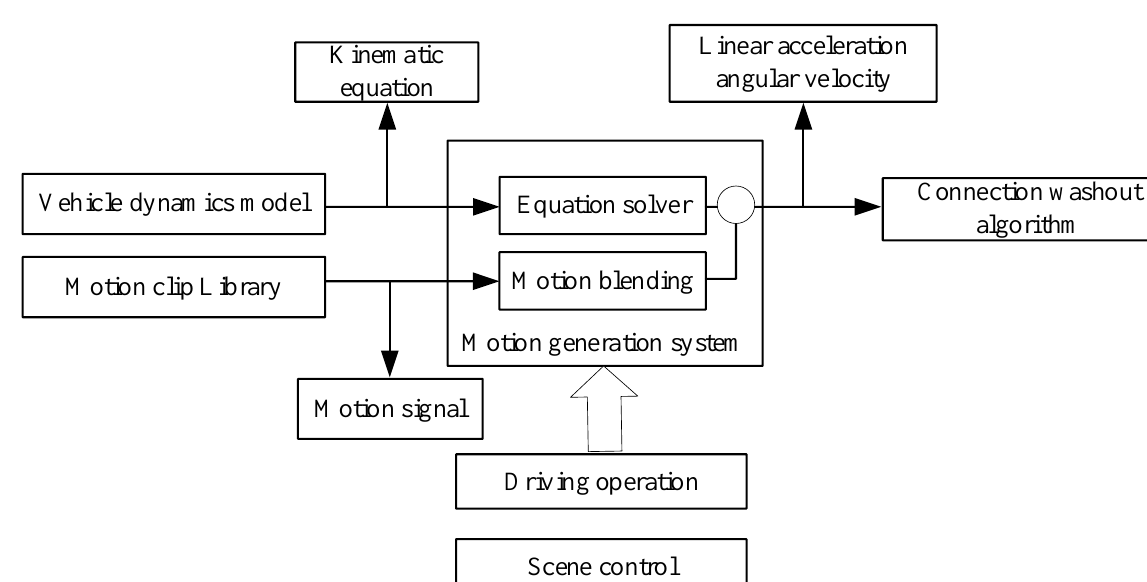
Figure 6. Crane motion simulation based on motion blending technology. 3. Streamlined Motion Blending Technology for Crane Motion Simulation 3.1. Analysis of Streamlined Motion Blending Technology The crane motion simulation scheme based on motion blending shown in Figure 6 can also be further optimized according to the characteristics of crane motion. In the motion components of the crane, the large-scale low-frequency motion caused by the acceleration and deceleration of the trolley needs to be separated by low-pass filtering, and replaced by the tilt coordinate method with the equivalent rotation motion. The motion platform can reproduce other small-scale high-frequency motions. Since the low-frequency motion and high-frequency motion are naturally separated from each other from the moment they are generated, it is only necessary to combine the low-frequency channel motion components converted by the tilt coordinate method with the high-frequency channel mo- tion components as the final driving instructions issued to the motion platform to realize the motion simulation of the crane motion with high fidelity. The structural diagram of the motion simulation system of the streamlined crane pro- posed in this paper is based on the improvement of the traditional motion blending tech- nology (as shown in Figure 7). Though, for this way to develop a dynamic simulation system, the technical route is clearer, the workload is greatly reduced, and the real-time performance is stronger.